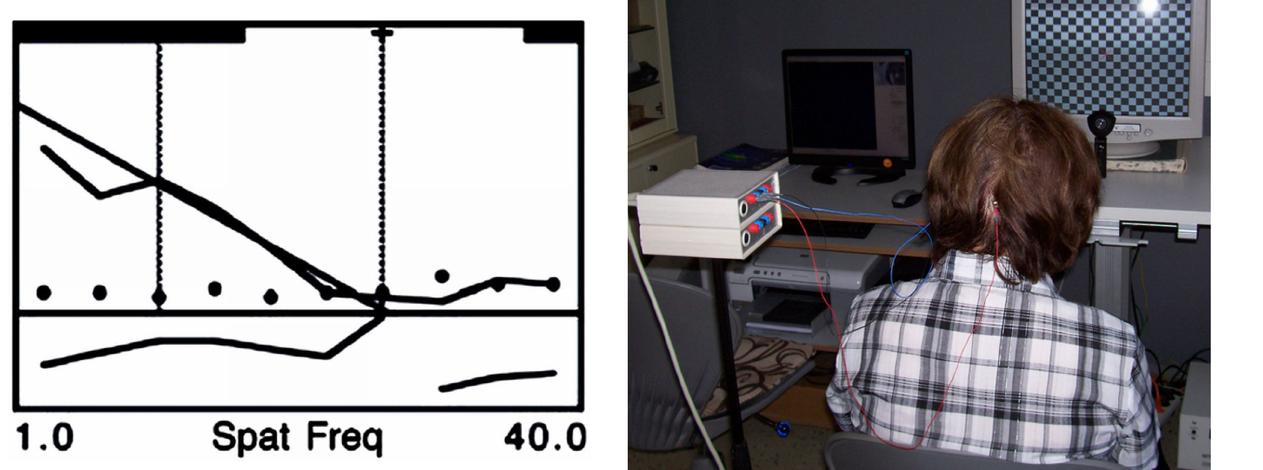
Fig. 2. sVEP visual acuity